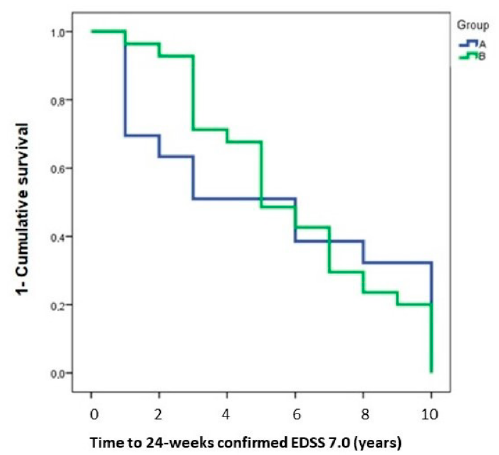
Figure 1. Time to 24-weeks confirmed EDSS 7.0 between the two groups. EDSS: Expanded Disability Status